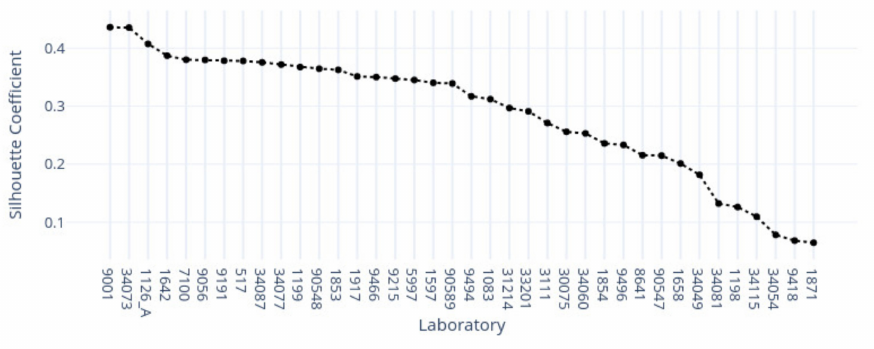
Figure 16. Silhouette scores for the second found cluster (C1) in colon samples across